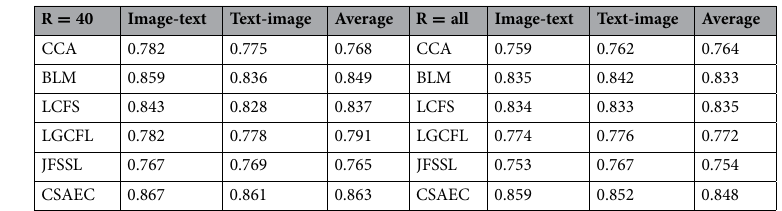
Table 3. MAP results of different methods